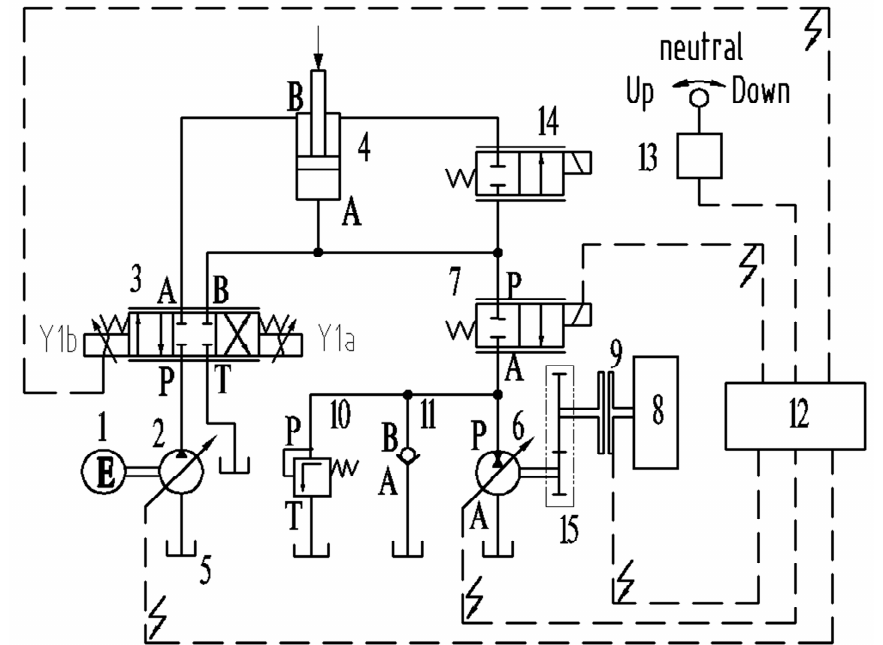
Figure 6. Configuration of the novel compound energy recovery system integrating flywheel and flow regeneration (FFERS) for the HE boom: 1, engine; 2, pump; 3, directional control valve; 4, boom cylinder; 5, reservoir; 6, hydraulic pump motor; 7, 2 / 2 directional control valve; 8, flywheel; 9, clutch; 10, safety valve; 11, check valve; 12, controller; 13, joystick; 14, flow regeneration valve; and 15, gearbox.